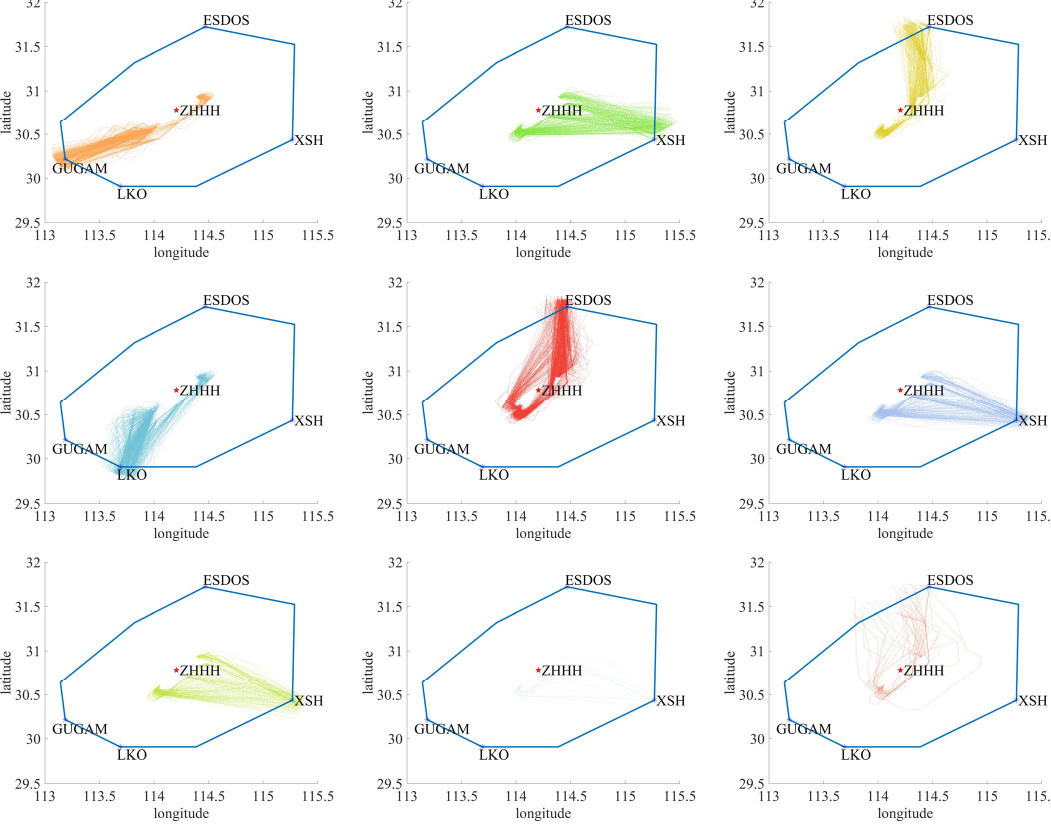
Figure 13. Clustering results of flight trajectories of ZHHH (DBSCAN).